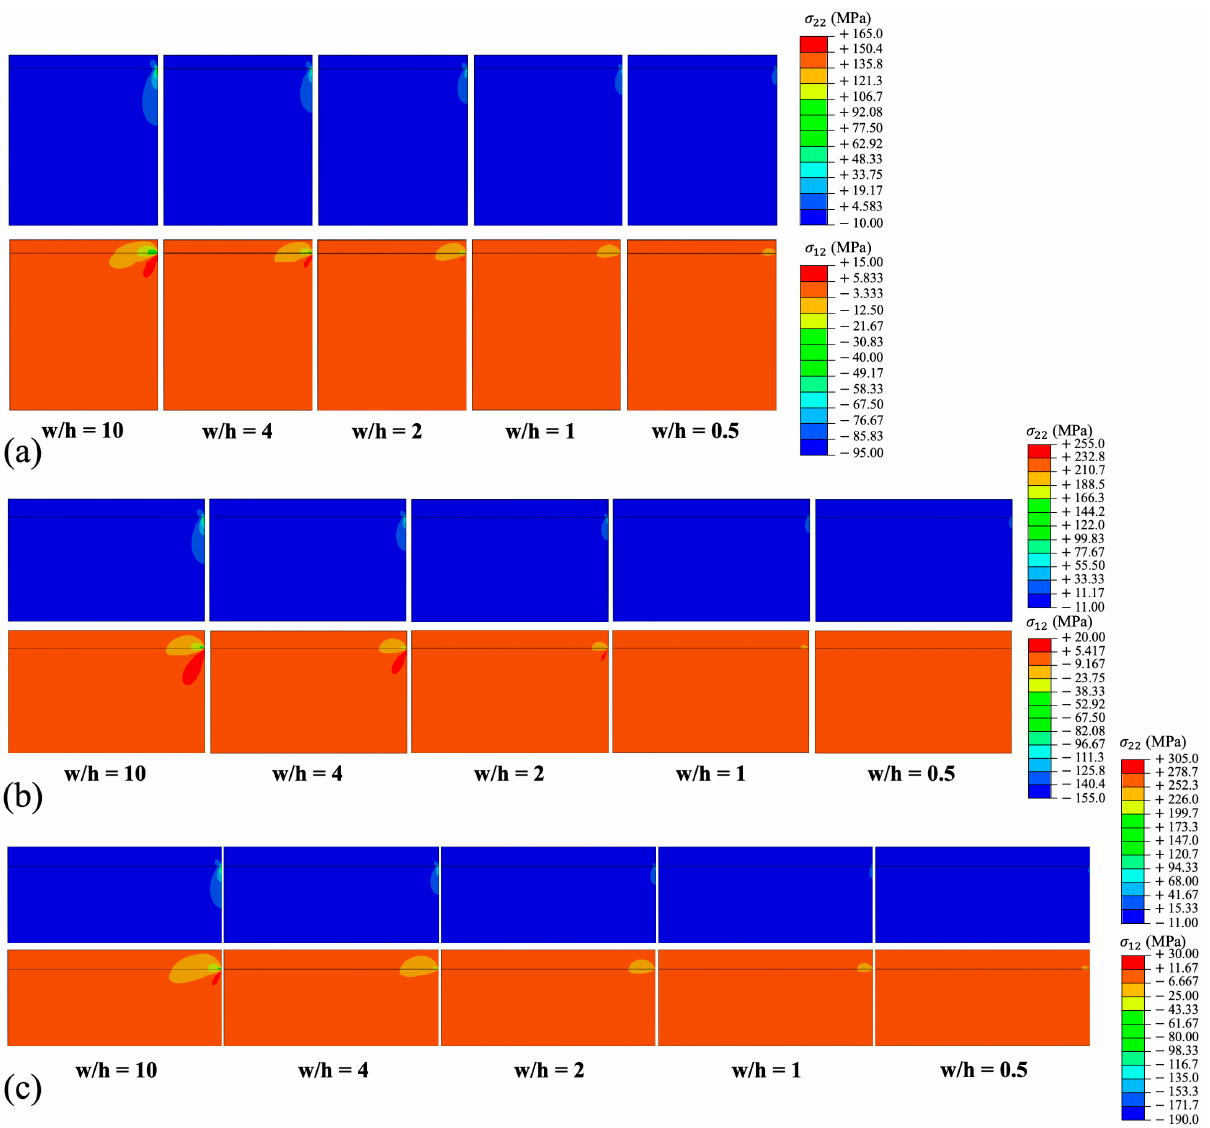
Figure 17. Stress distribution: ( a ) 0.3, ( b ) 0.6, and ( c ) 0.9 mm thick TC.